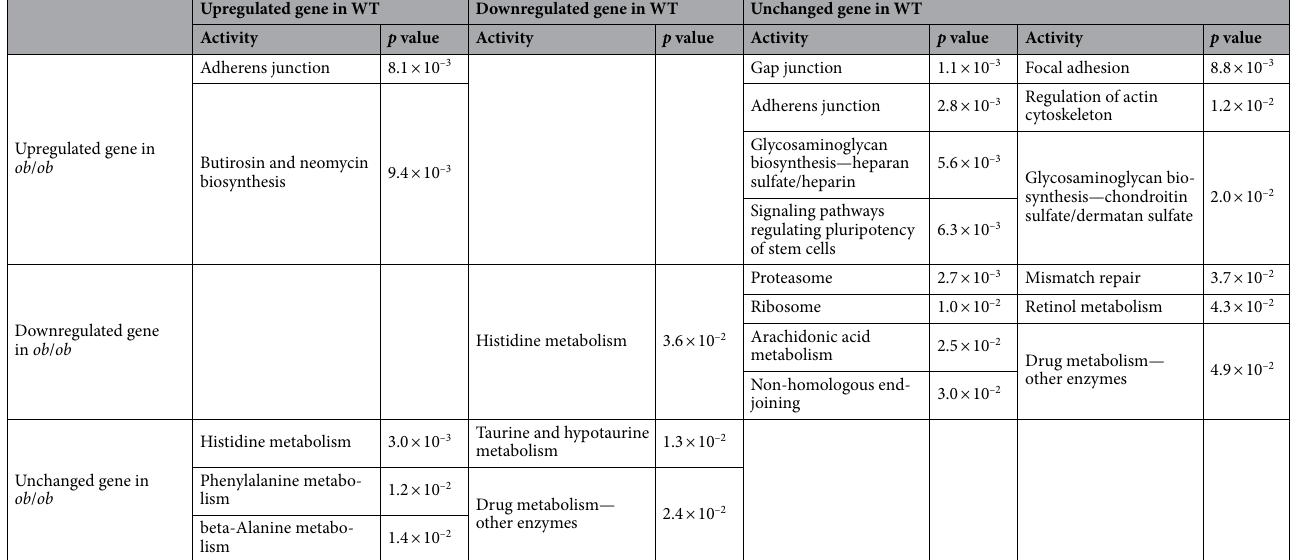
Table 1. Pathway enrichment analysis of the glucose-responsive genes. Pathways with p value < 0.05 are